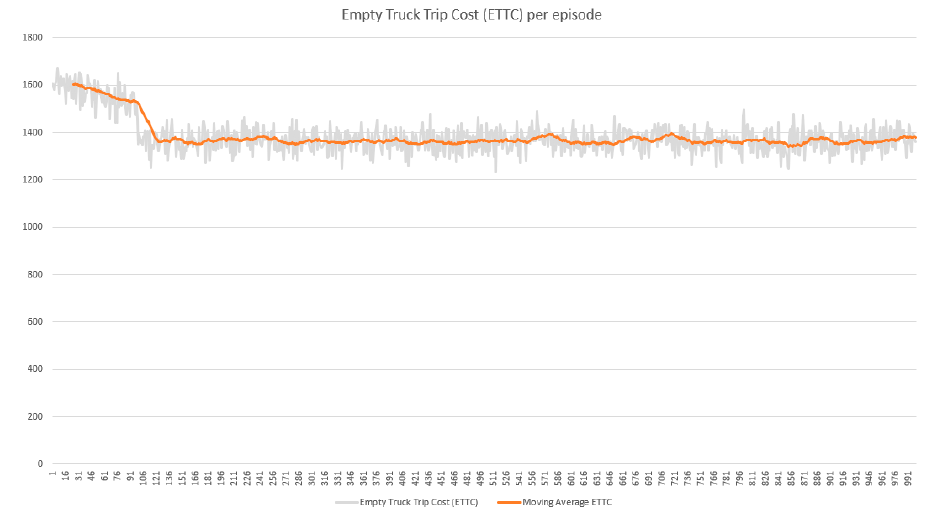
Figure 11. Empty-truck trip cost (ETTC) per episode.